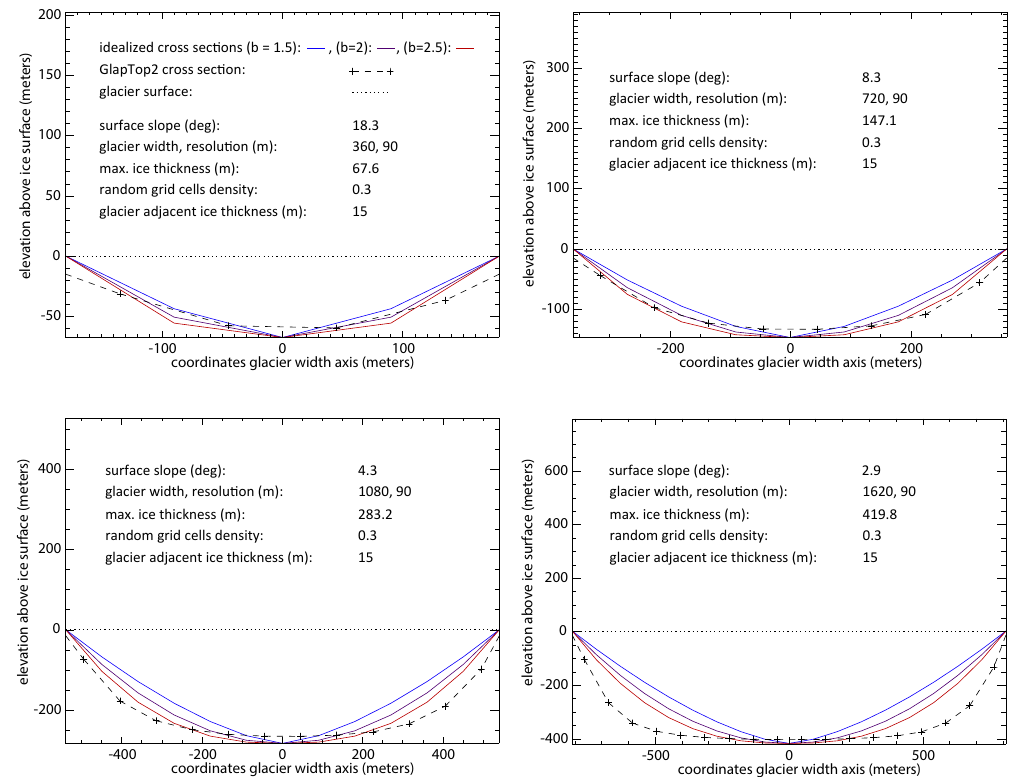
Figure A2. Comparison of idealized glacier cross sections to GlabTop2 cross sections for four different combinations of surface slope and glacier width. For the calculation of the idealized profiles three different b values have been used. Note that the GlabTop2 cross sections are not perfectly symmetrical due to the random sampling of inner glacier